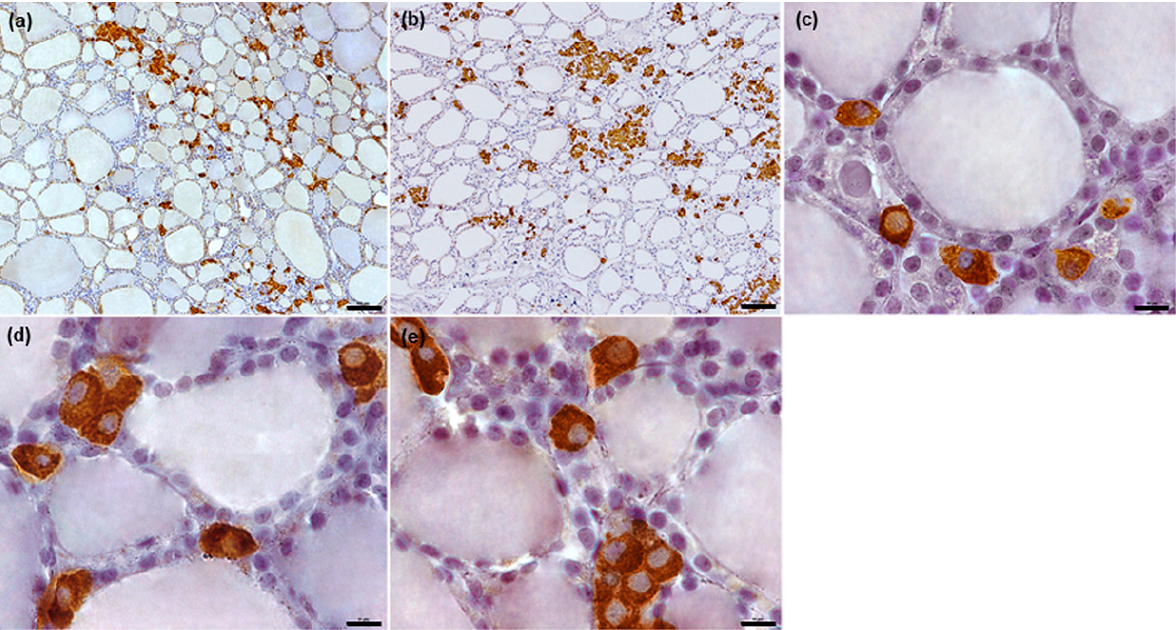
Figure 1. Representative images of canine C thyrocytes arrangement and morphology. ( a , b ): Section of thyroid parenchyma with C thyrocytes arranged in groups of various sizes. ( c – e ): Typical morphology of C thyrocytes in dogs. Immunoperoxidase staining with anti-calcitonin antibody, scale bars: ( a , b ) = 100 µm, ( c – e ) = 10 µm.